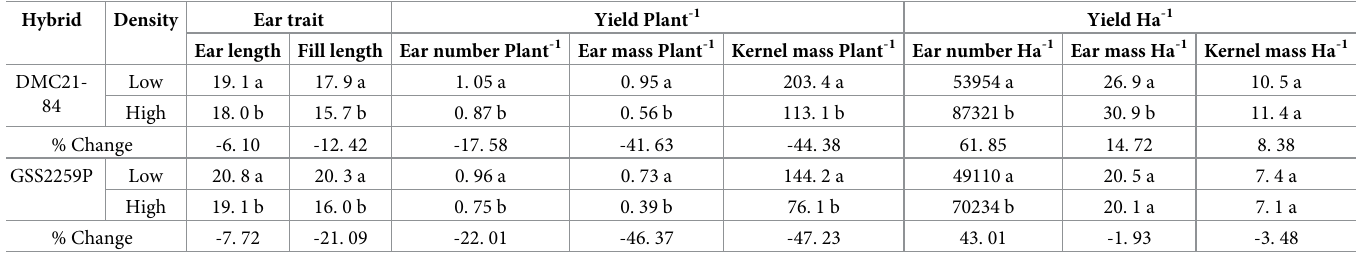
Table 2. Phenotypic yield trait results of two sweet corn hybrids in high (96,100plants ha -1 ) and low (51,500 plants ha -1 ) densities and the percent change of each phenotypic trait of two sweet corn hybrids from low to high plant densities.